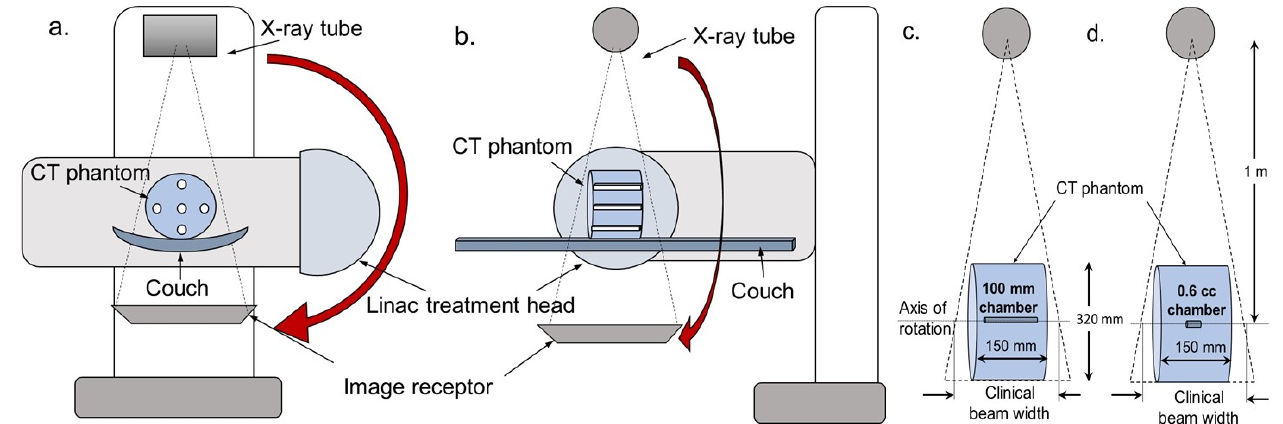
Figure 5. Arrangement being used for measurement of cumulative dose at the centre of a CT body phantom. The X-ray source and image receptor are typically mounted at 90 ◦ from the treatment head of a medical linear accelerator. The figure shows schema of the measurement set-up in ( a ) the axial plane and ( b ) the sagittal plane. Measurements would be made with in a CT standard phantom with ( c ) a 100 mm CTDI ionization chamber and/or ( d ) a 0.6 cc Farmer type ionization chamber.